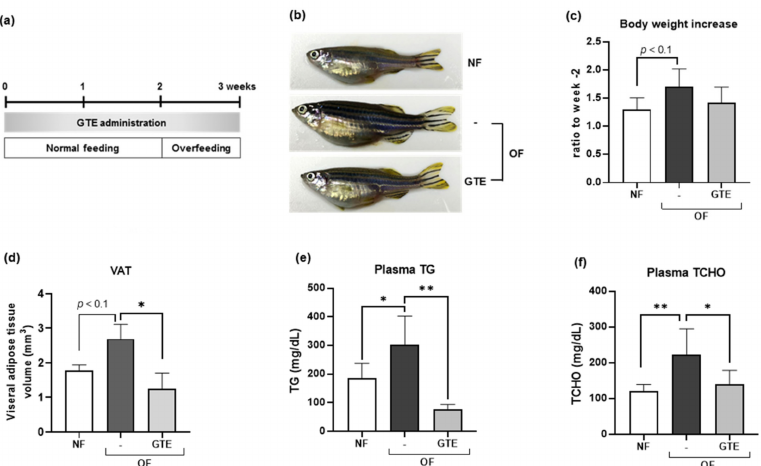
Figure 2. GTE reduced VAT and decreased plasma triglycerides (TG) and total cholesterol (TCHO) levels in adult obese zebrafish. ( a ) Diagram of the overfeeding experiment. GTE administration and overfeeding started on week 0 and week 2, respectively. ( b ) Typical images of normal-feeding (NF) and overfeeding (OF) zebrafish with or without GTE. ( c ) Change in body weight during the feeding experiment. ( d ) GTE reduced VAT in OF zebrafish. GTE suppressed the increase of plasma TG ( e ) and TCHO ( f ) in OF zebrafish. * p < 0.05, ** p < 0.01, n = 5, error bars indicate